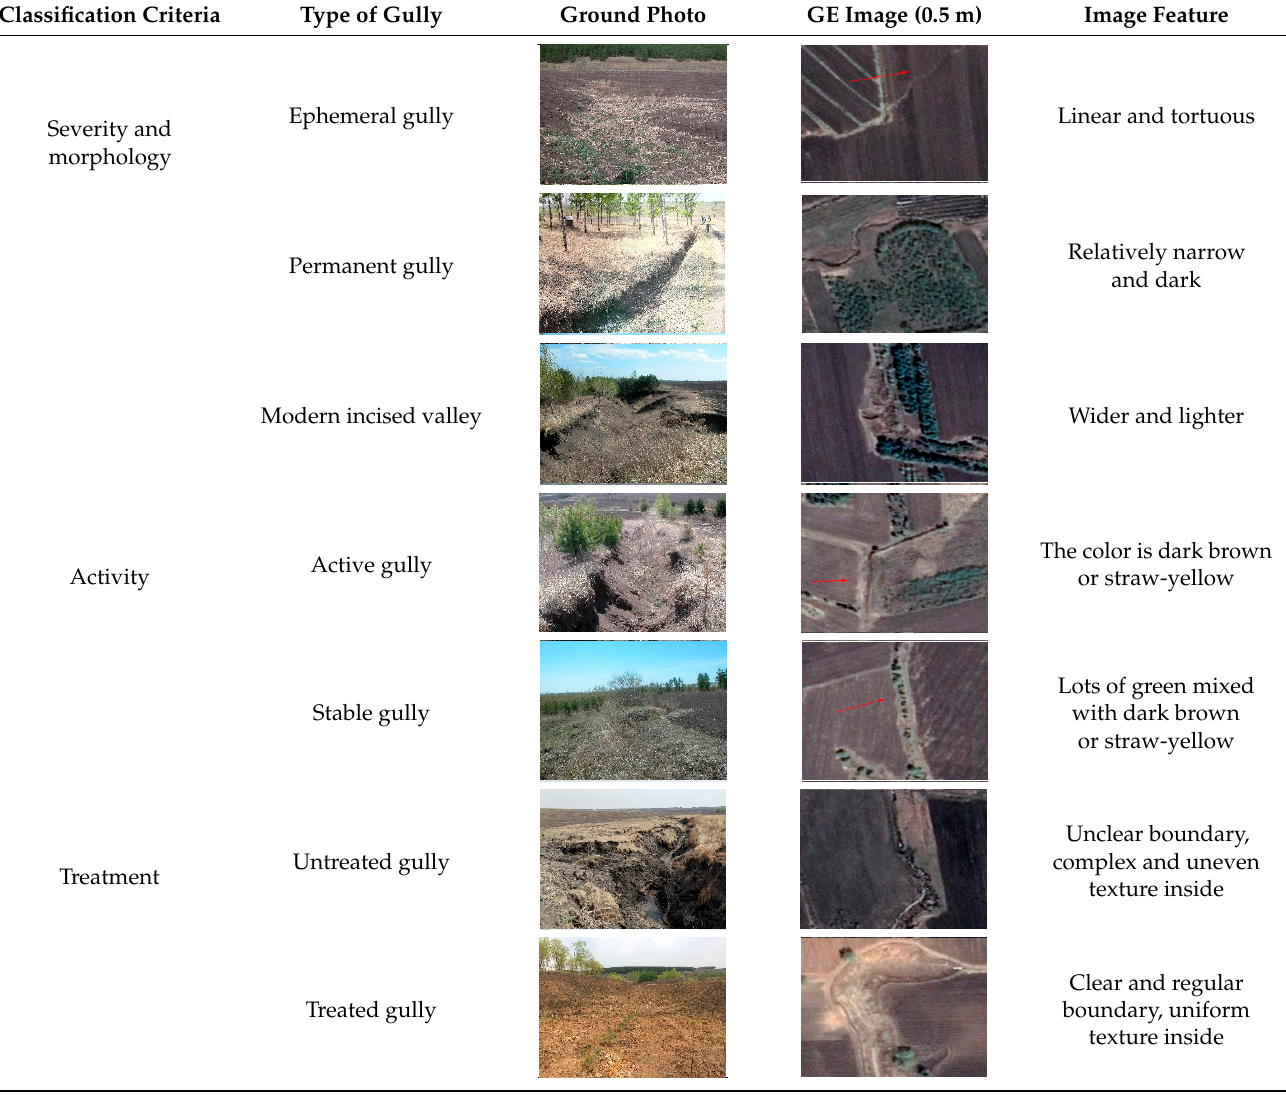
Table 1. Types and interpretation marks of gullies.